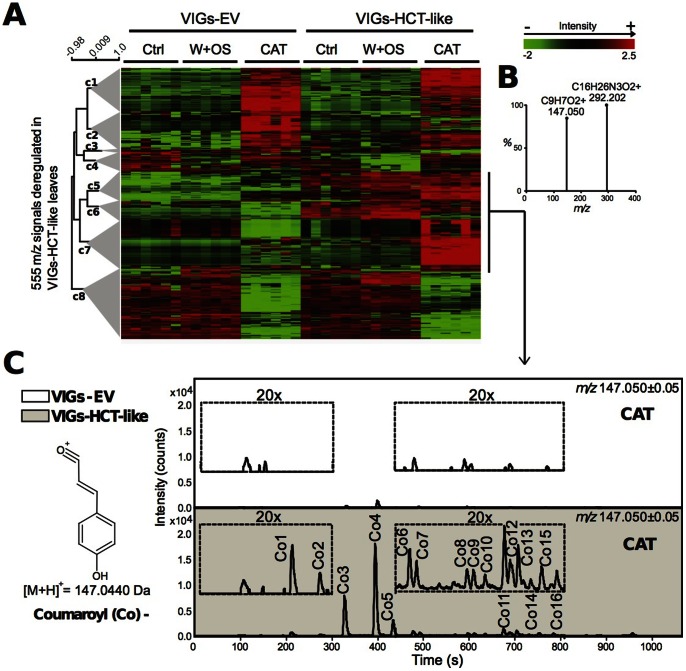
Silencing HCT-LIKE diverts activated p-coumaric acid to coumaroyl-containing PAs.(A) Hiearchical clustering analysis involving 555 deconvoluted m/z features differentially regulated (2-fold change, P-value <0.05) in leaves harvested from uninduced, Manduca sexta-attacked and W+OS-treated VIGs-HCT-LIKE compared to similarly treated VIGs-EV plants. (B) Many of the in-source generated pseudo-spectra reconstructed by CAMERA analysis for highly altered ion clusters (c5, c6 and c7) contained the typical signature fragments for coumaroyl moieties ([M+H]+
m/z 147.04±0.05) released after the cleavage of the ester bond linking them to a core molecule (sugar, polyamines, small acids, etc). (C) Representative ion chromatograms (n = 5 biological replicates) calculated for coumaroyl-containing metabolites in M. sexta-attacked leaves. “Co” numbers refer to main the PAs summarized in Table 1. Ctrl: uninduced control leaves; W+OS: mechanically wounded leaves treated with M. sexta oral secretions; CAT: M. sexta caterpillar-attacked leaves.